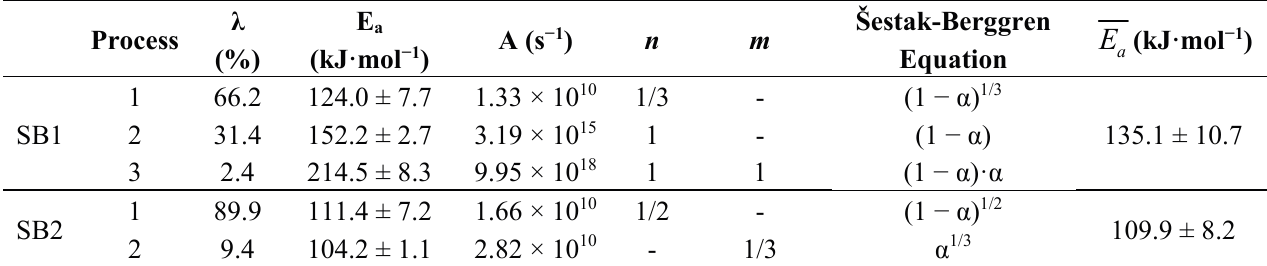
Table 2. The results of kinetic analysis by the NPK method.